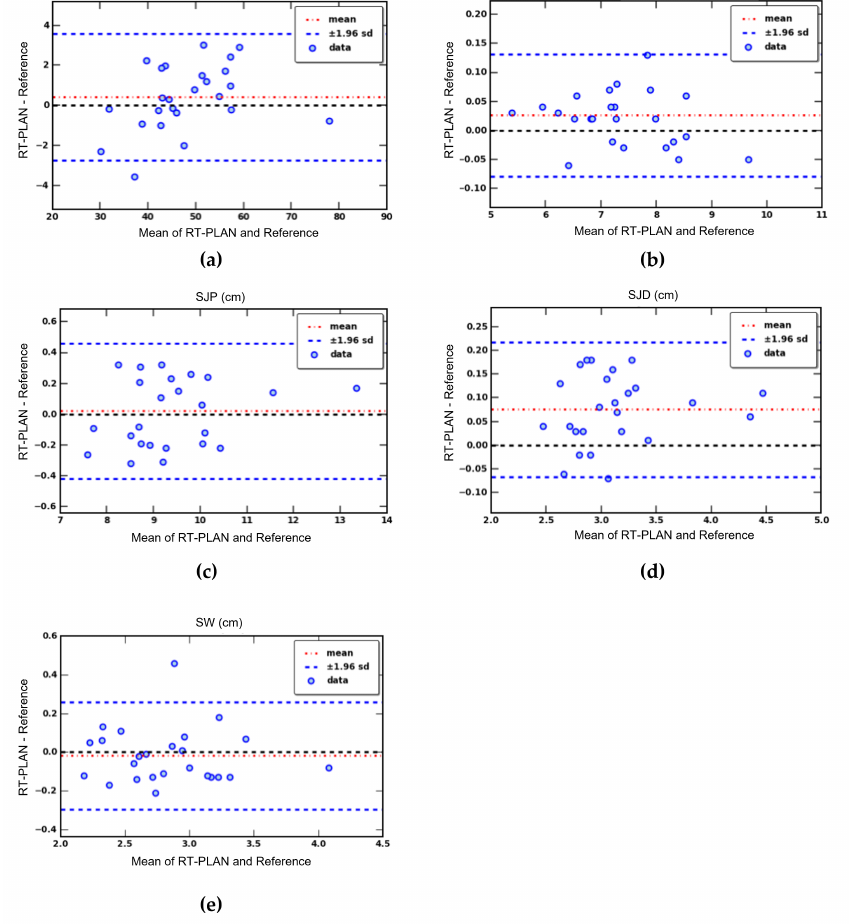
Figure 4. Bland–Altman plot for α angle ( a ), asD ( b ), SJP ( c ), SJD ( d ) and SW ( e )